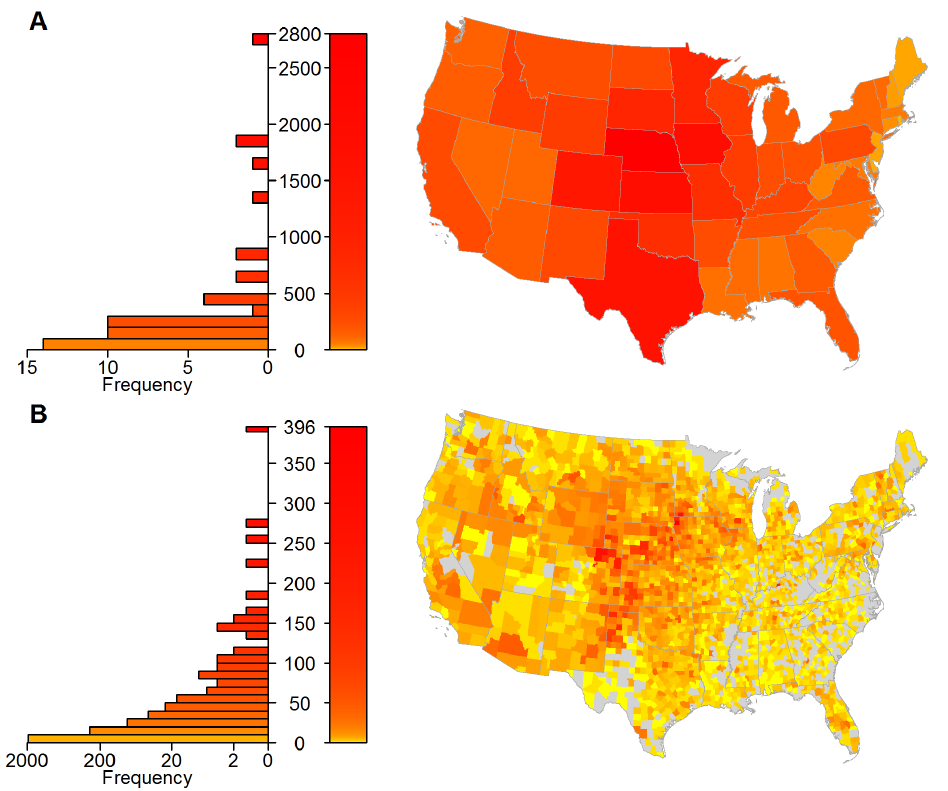
Figure 4. In-degree distributions of the cattle movement network from a 10% sample of ICVIs. The network is aggregated into (A) state and (B) county nodes. The left-hand graphs show the frequency distribution of node in-degrees, whilst the maps show the value for that area. A logarithmic color scale is used to differentiate high (red) from low (yellow) in-degree. Counties with no sampled in-shipments are indicated in gray.